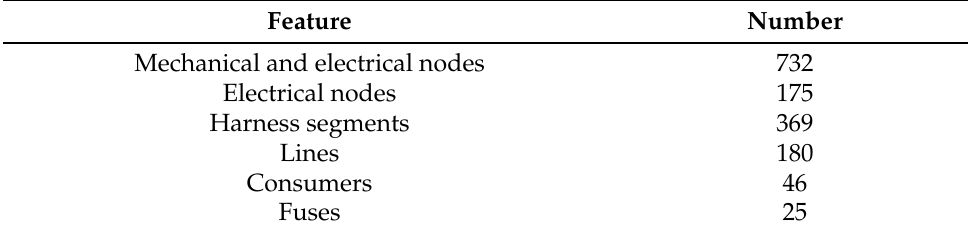
Table 1. Network characteristics of the studied